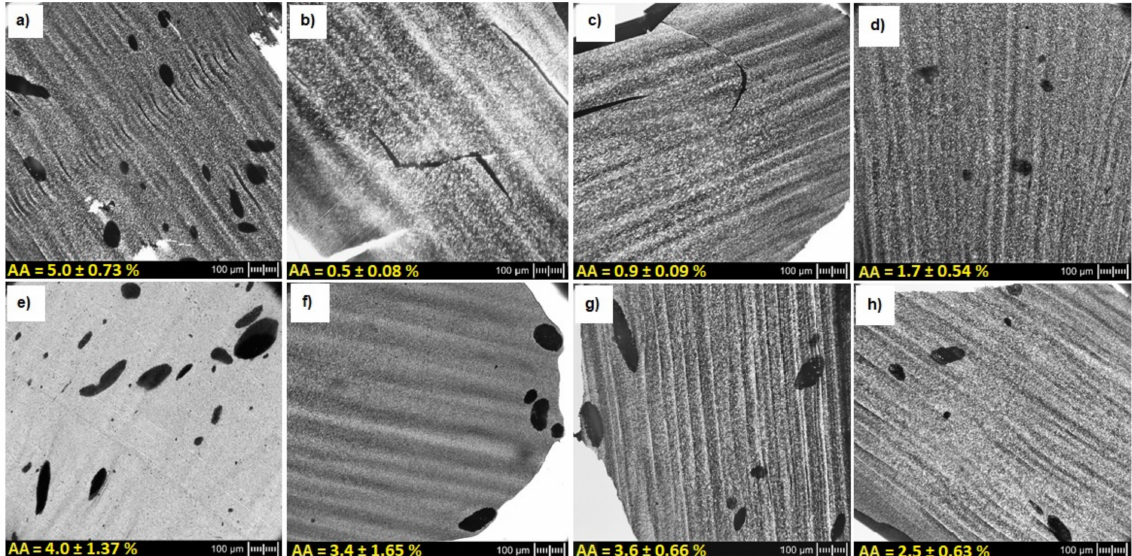
Figure 2. Optical micrographs illustrating the state of MWCNTs’ agglomerate dispersion at different temperature and MWCNT content: ( a ) PPS + 10 wt% MWCNT masterbatch, ( b ) PPS + 10 wt% MWCNT (T = 290 °C), ( c ) PPS + 10 wt% MWCNT (T = 305 °C), ( d ) PPS + 10 wt% MWCNT (T = 320 °C), ( e ) PPS + 2 wt% MWCNT (T = 320 °C), ( f ) PPS + 4 wt% MWCNT (T = 320 °C), ( g ) PPS + 6 wt% MWCNT (T = 320 °C), ( h ) PPS + 8 wt% MWCNT (T = 320